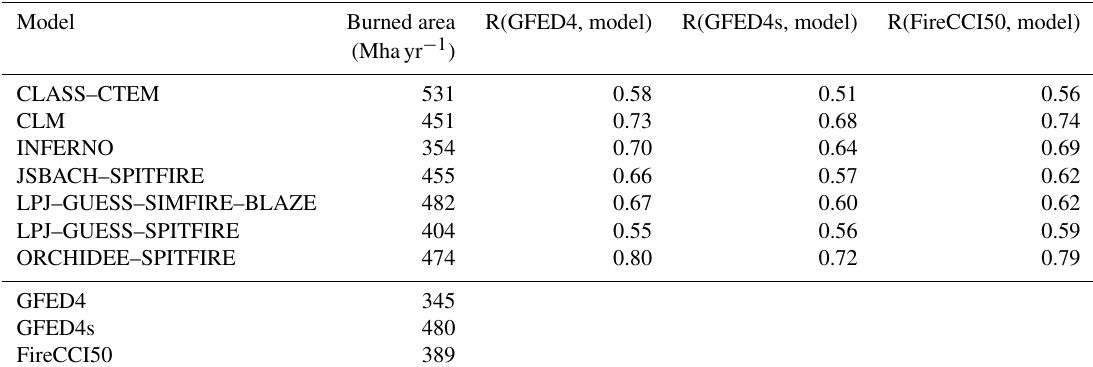
Table 3. Global burned area averaged over 2001–2013 in megahectare per year (Mhayr − 1 ) and the Pearson correlation coefficients between the baseline experiment SF1 for all FireMIP models and the respective observation data. We use a square root transformation on both model and observations. All correlation coefficients are significant ( p value <